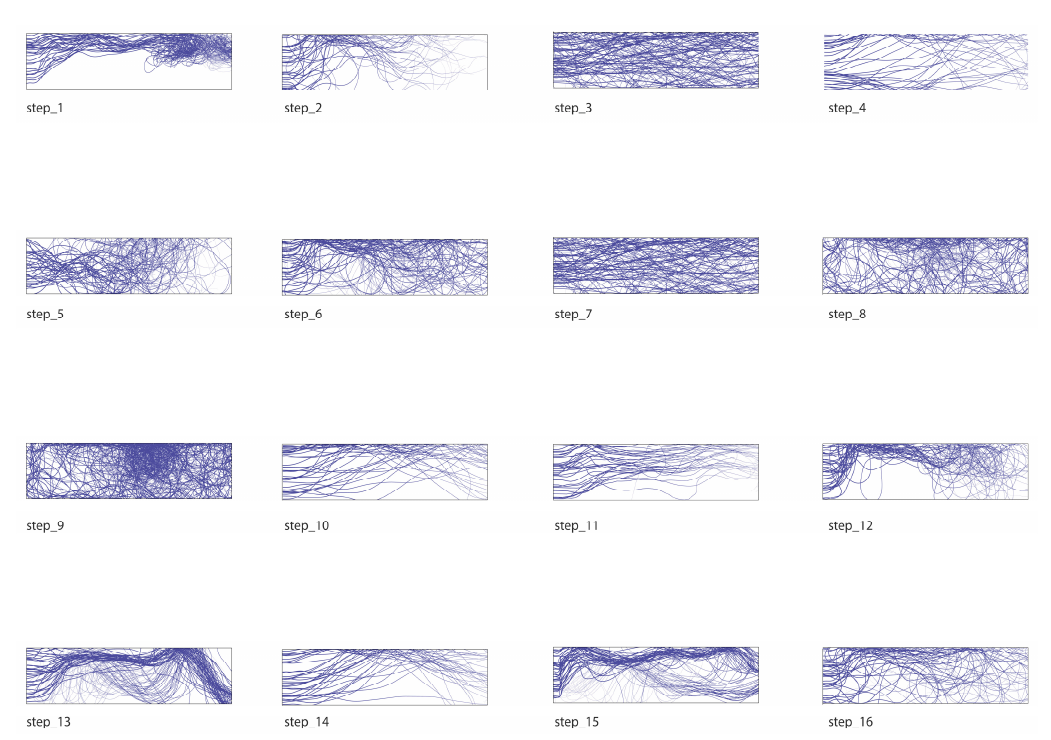
Figure 3. Flocking sequence with different behavioral